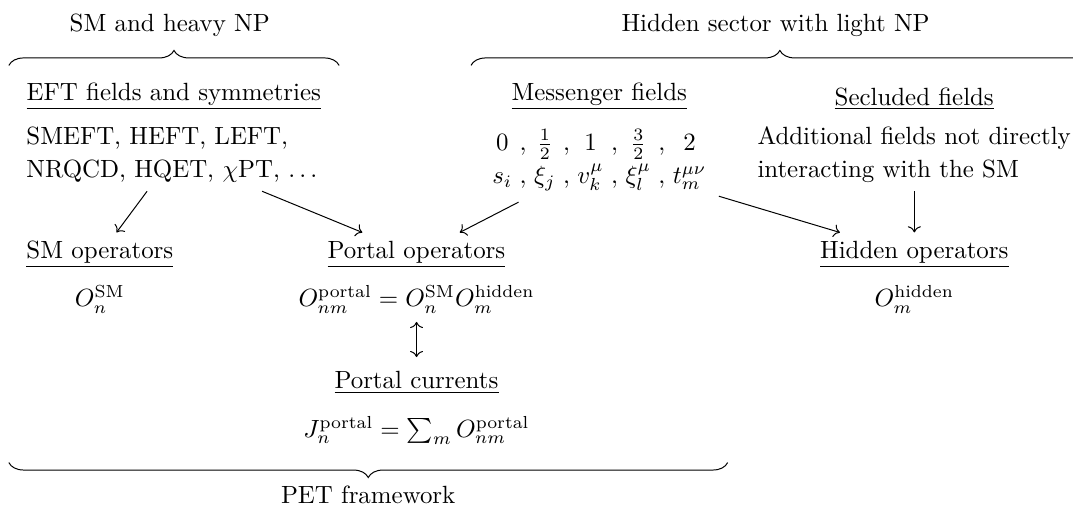
Figure 1. The PET framework extends a given EFT of the SM by combining its operators with portal operators that couple the SM DOFs to messenger fields that are dynamic at the relevant energy scale. The portal operators O portal can be collected into a set of portal currents J portal that nm n allow for a spurion analysis and for e.g. model-independent bounds. Here n and m symbolically label SM and hidden sector operators, respectively, so that L = O SM . The PET framework J portal portal n n is independent from additional secluded particles that do not interact directly with the SM